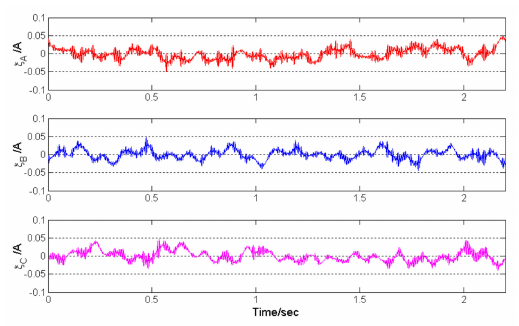
Figure 10. Harmonic currents of i d = 0 control.